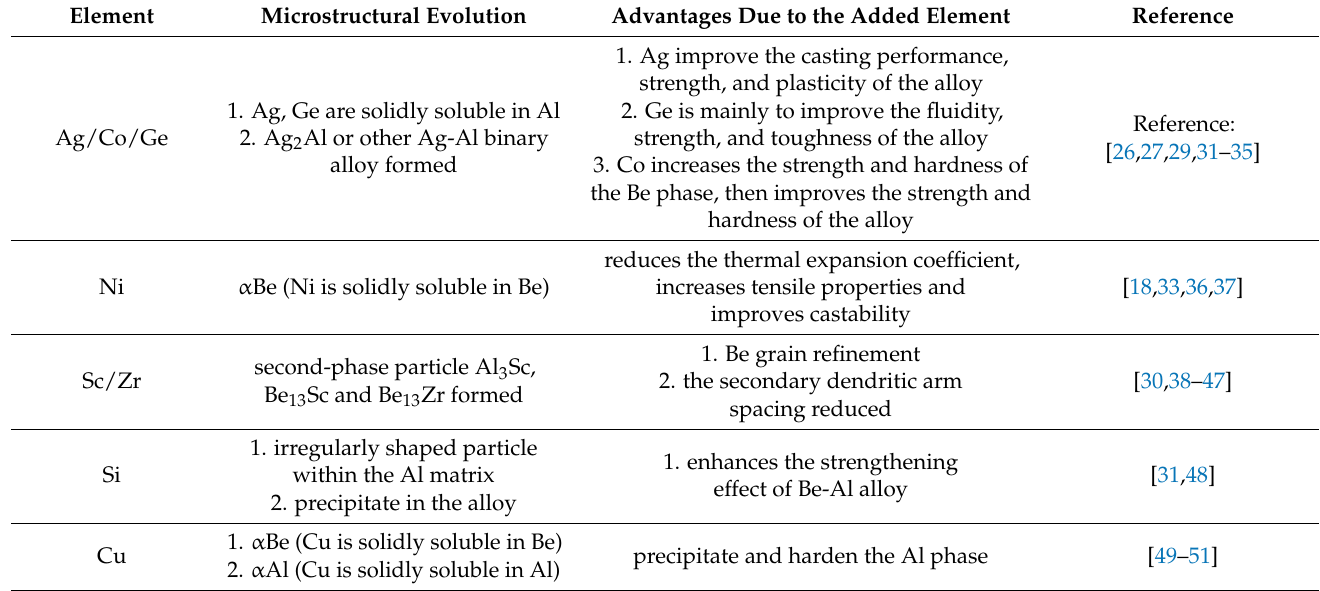
Table 3. The effect of adding elements on the casting process of Be-Al